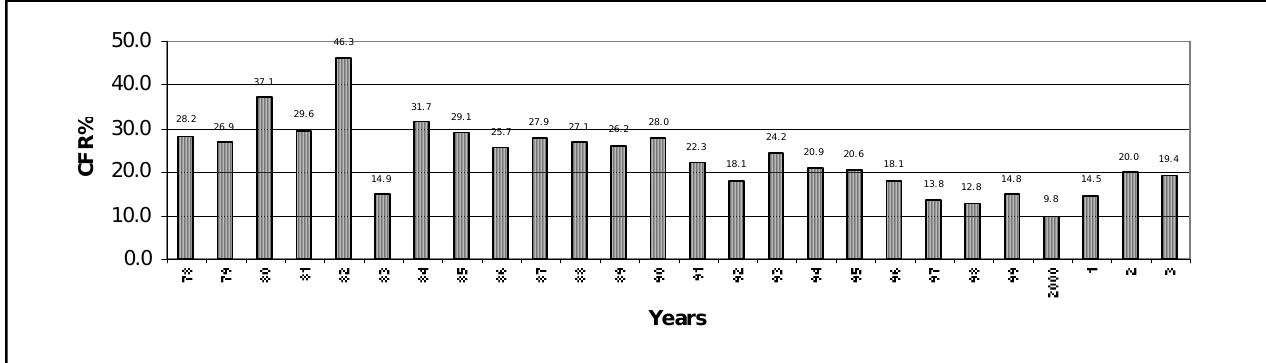
Fig. 3 : Case Fatality Rate Due to JE During Period 1978 - 2003, Nepal.